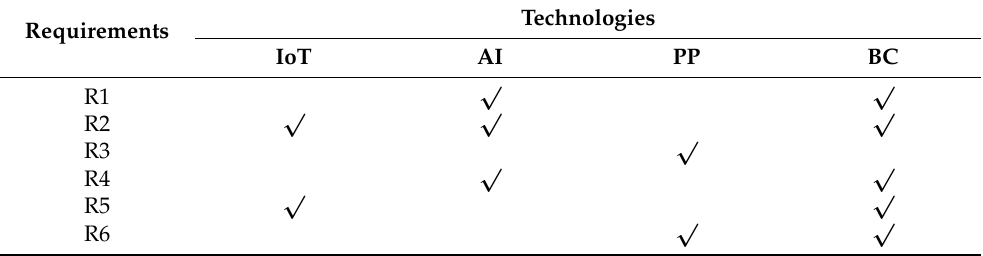
Table 2. Technologies for requirements of food safety.